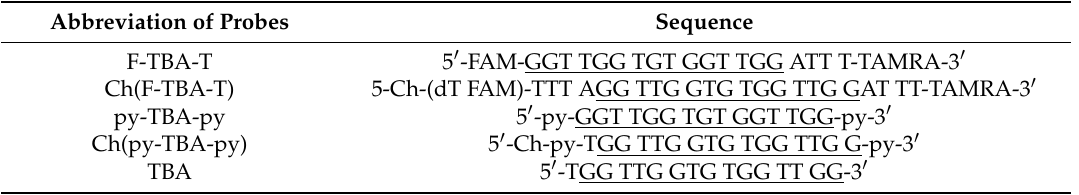
Table 1. Fluorescent oligonucleotide probes used in this